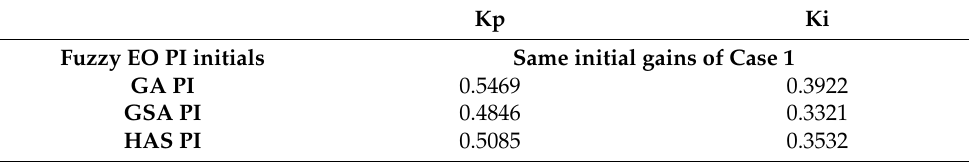
Table 4. Gains of controller in case 3.